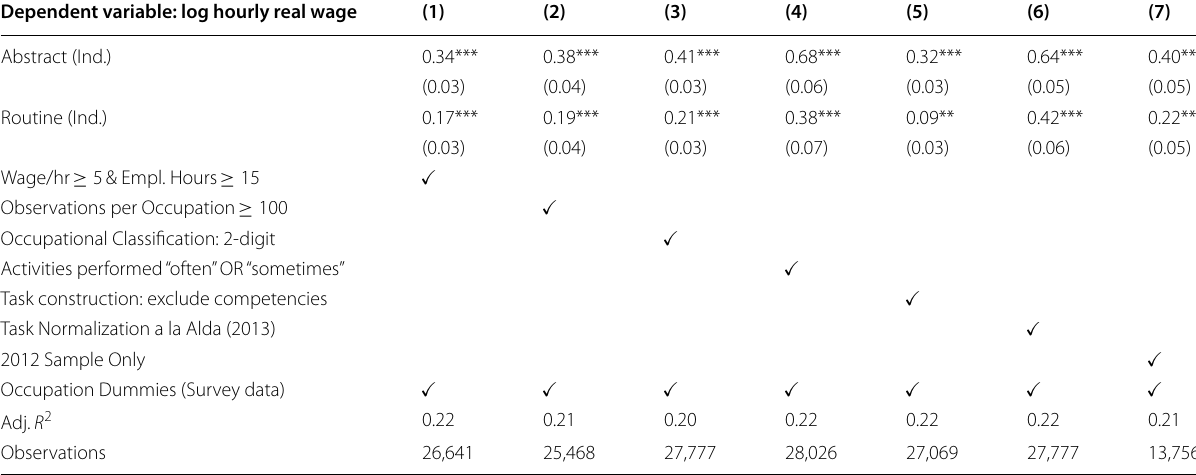
Robust standard errors in